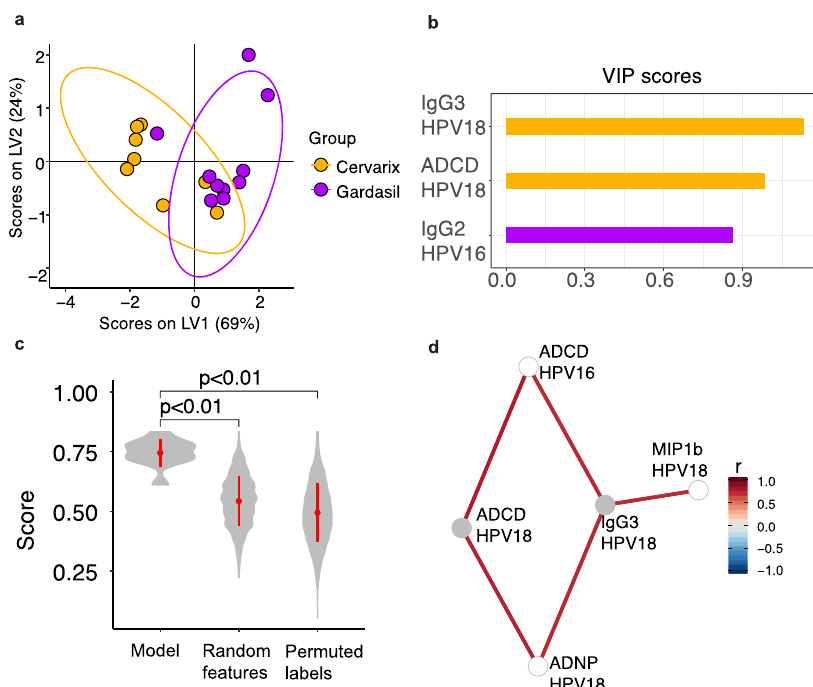
Fig. 5 Multivariate analysis shows important features driving the separation of the two vaccine groups. a , b Samples at month 13 visualized using the fi rst two latent variables (LV1 and LV2) from the Partial Least Square Discriminant Analysis (PLSDA) model ( a ) built with elastic net-selected features ( b ). Variable Importance in Projection (VIP) scores of the selected features are shown. Q 2 values of the PLSDA model for LV1 and LV2 were 0.487 and − 0.178, respectively. c Violin plots showing the distribution of 5-fold cross-validated accuracy scores from the original PLSDA model and alternate models. The accuracy of the original PLSDA model was signi fi cantly higher than the accuracy of the random features model and the permuted labels model. d Co-correlates of the elastic net-selected features enriched for the Cervarix ® group. Features shown are those with | r | >0.7 and False Discovery Rate (FDR) < 0.05 after multiple test correction by the Benjamini-Hochberg procedure for all comparisons between features at month 13. ADCD antibody-dependent complement deposition ADNP